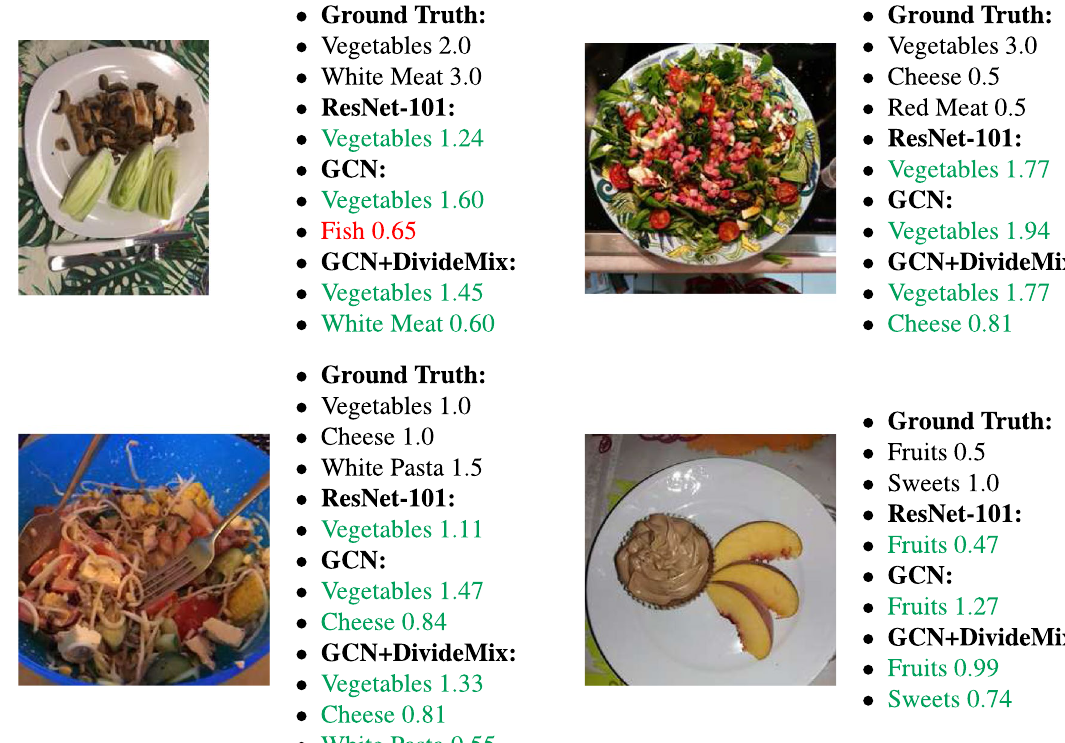
Figure 4. Results from the three methods for the food recognition and the serving size estimation. Categories appear in green and red for correct and wrong predictions